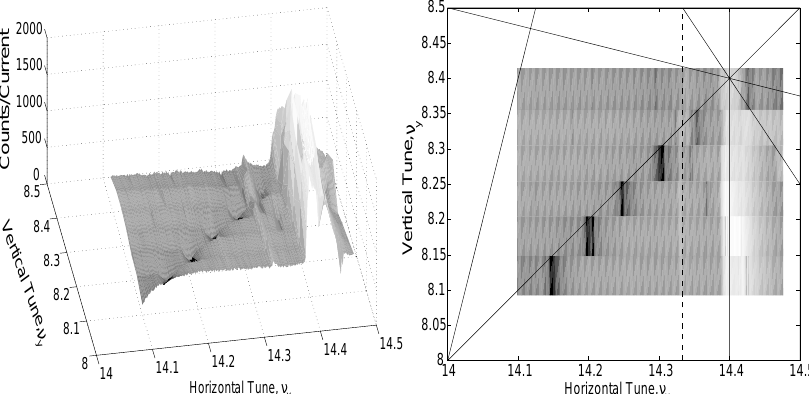
FIG. 12. Larger area tune scans of the lattice after the optic is corrected. At each horizontal and vertical tune, the count rate (as measured in a gamma counter) divided by beam current is plotted. Data are drawn as a hill plot (left) and as a contour plot (right). All “allowed” resonances up to 5th order are plotted (solid line). The resonance n (cid:120) (cid:173) (cid:52)(cid:51) is plotted as a dashed line. small increase in count rate near the (cid:51) n (cid:120) resonance. This indicates that periodicity is not perfectly restored.